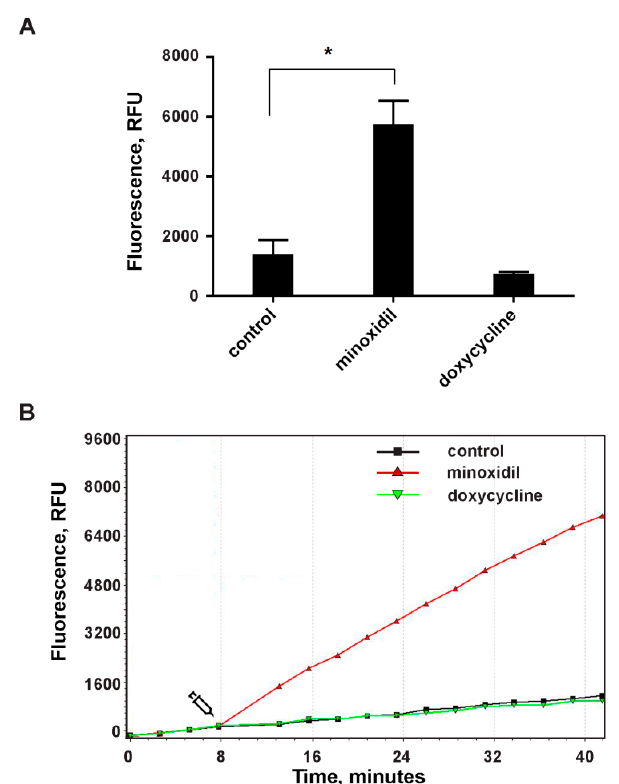
Figure 4. The effect of minoxidil and doxycycline on ROS formation during the adhesion of neutrophils to the fibronectin-coated substrate. H 2 DCF-DA-labelled neutrophils were cultured in fibronectin-coated flat bottom plates without additives or in the presence of 200 µM minoxidil or 20 µM doxycycline at 37 °C, 5% CO 2 . DCF (diacetate (H 2 DCF-DA) oxidation product) fluorescence signals (ex. 485 nm, em. 538 nm) were monitored with 2 min intervals. A. Values represent the means ± SEM of fluorescence intensities (relative units) 30 min after the addition of inhibitors from three independent experiments. *— p < 0.05 (one-way ANOVA followed by Tukey’s multiple comparison test). B. Representative DCF fluorescence kinetic curves for control (square, black), minoxidil (triangle, red) or doxycycline (inverted triangle, green) treated neutrophils.